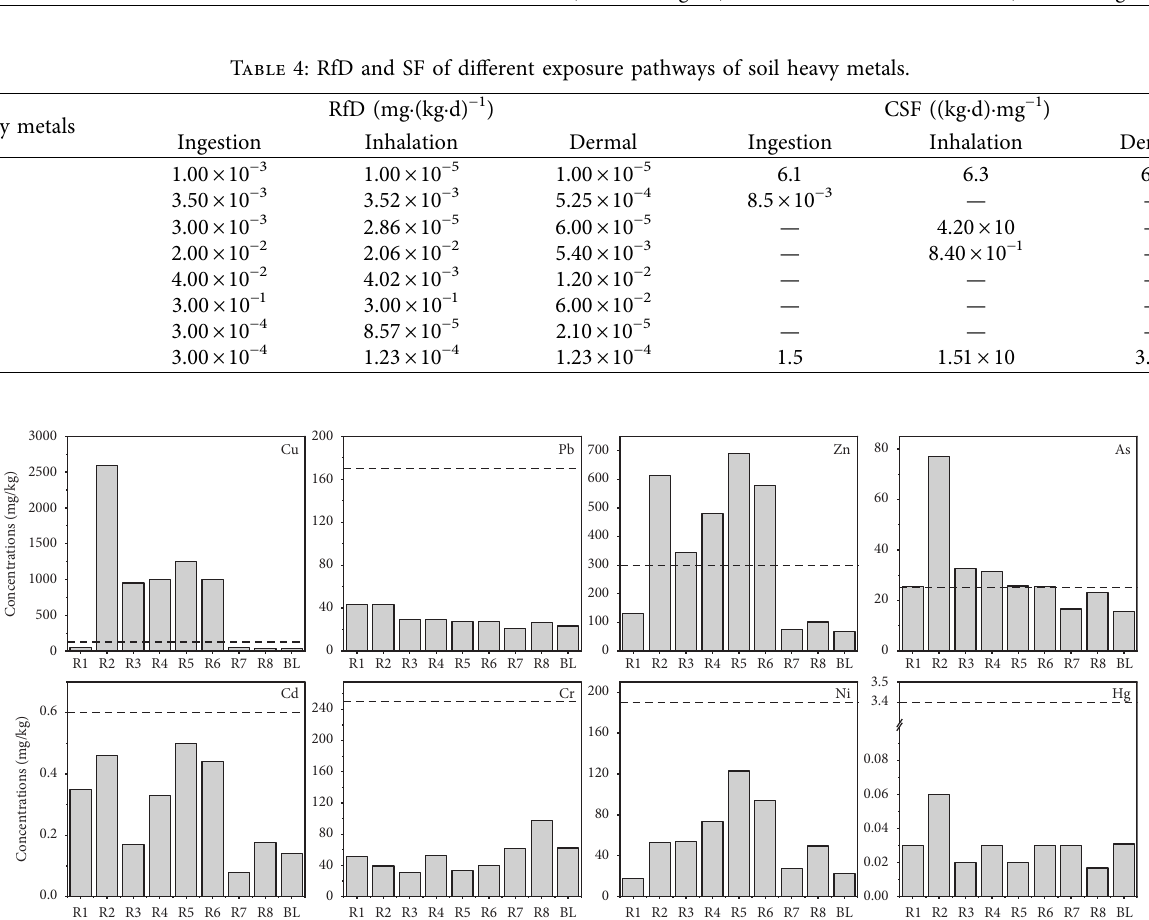
Figure 2: Heavy metal content in the sediments of the Rongna